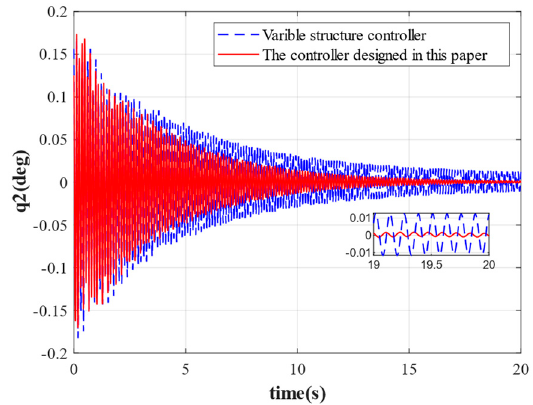
Figure 6. Second ‐ order elastic vibration mode without external interference.